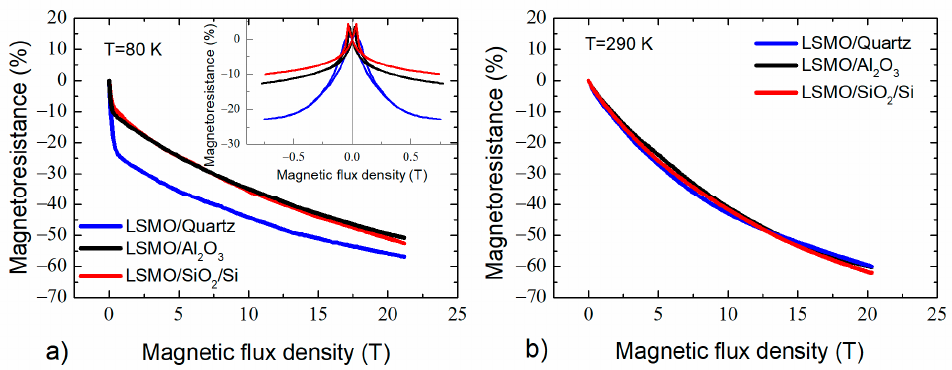
Figure 11. Magnetoresistance dependences on magnetic flux density at ( a ) T = 80 K and ( b ) T = 290 K for 360 nm thick films grown on quartz, Al 2 O 3 and Si/SiO 2 substrates. The inset— MR vs. B measured by using a permanent field electromagnet.